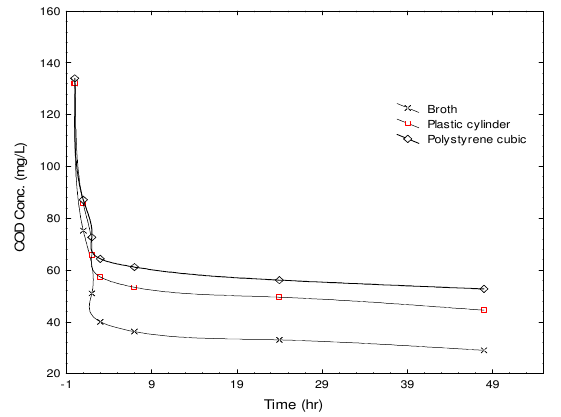
Fig. 18. Effect of Packing type on the concentration level of NO 3 pollutant with time at T=25 o C, pH 7, and sterilized wastewater.